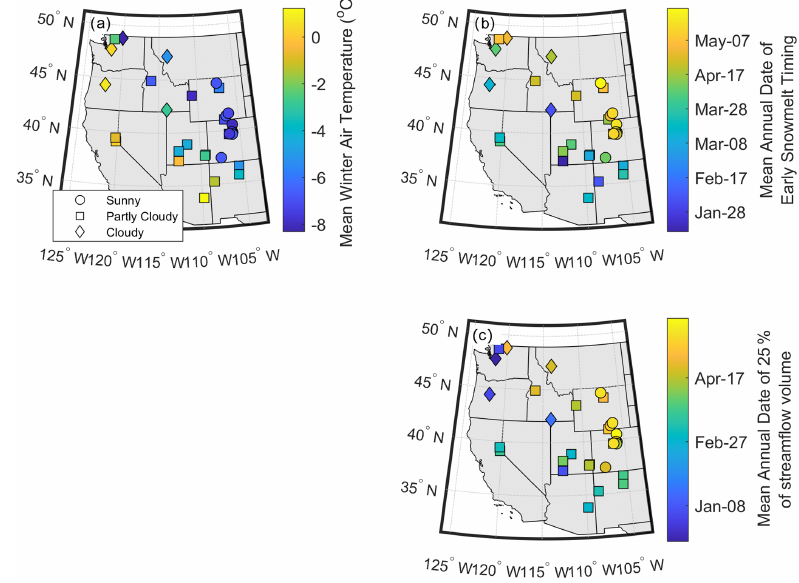
Figure A2. (a) CAMELS mean winter (November to February) air temperature, (b) mean annual DOS20, and (c) mean annual DOQ25. Symbols (circle, square, and diamond) represent the mean annual percentage of clear-sky snowmelt days, where sunny sites have > 90% clear-sky snowmelt days, partly cloudy have between 70% and 90%, and cloudy have < 70%; clear-sky snowmelt days are defined as those with more than 80% of the potential clear-sky solar radiation.